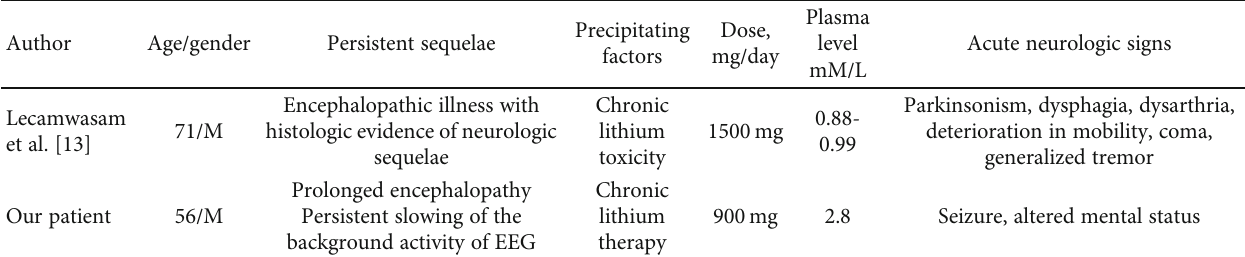
Table 1: Patients with persistent encephalopathic illness as a sequela of lithium